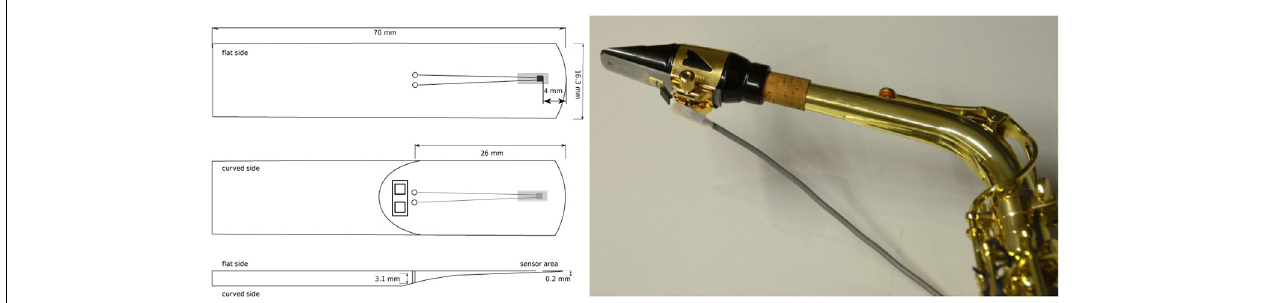
FIGURE 2 | Left: Synthetic alto saxophone reed, equipped with strain gauge sensor (2mm), glued with 4mm distance from the tip on the flat side of the reed, to avoid direct lip/tongue contact with the sensor. Right: Mouthpiece with sensor reed used in the experiments to capture reed bending during performance.